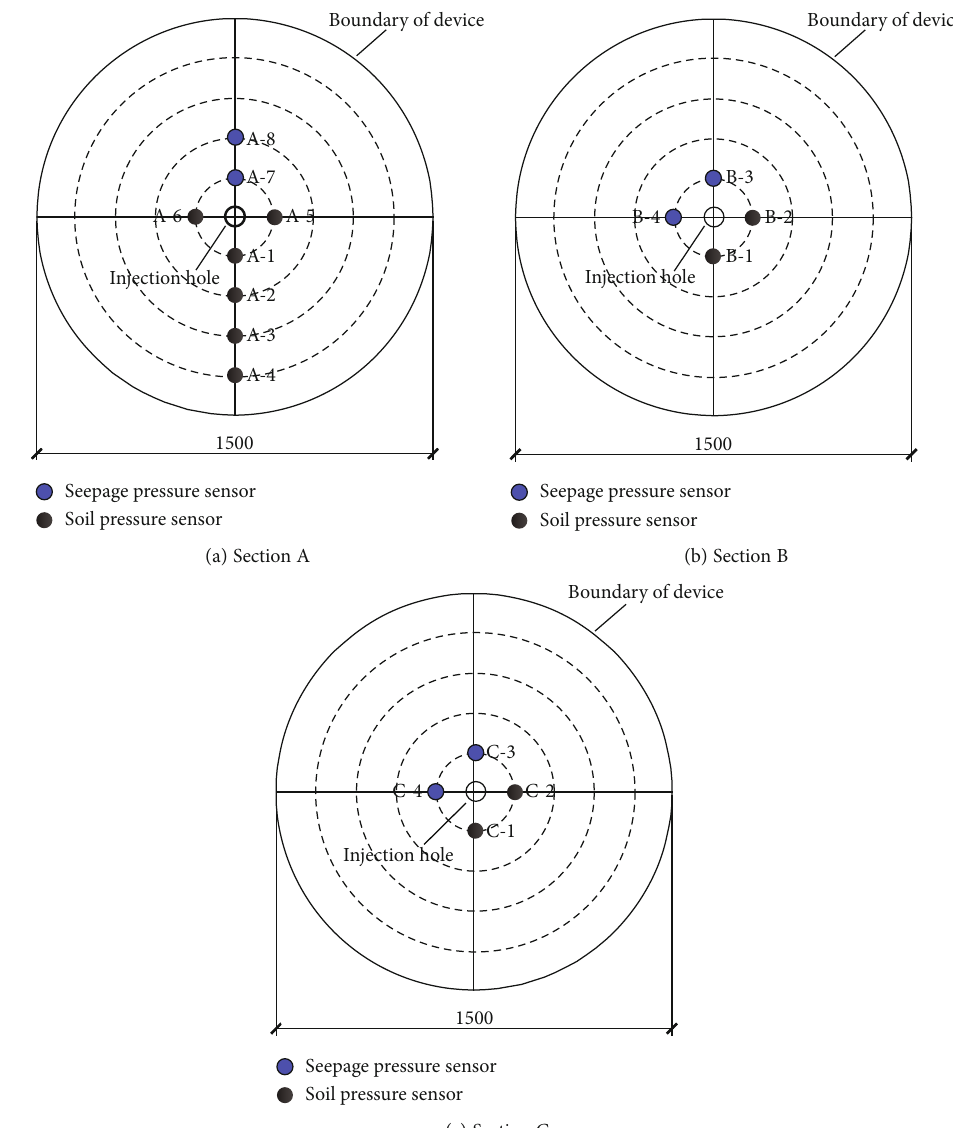
Figure 7: Distribution of soil pressure sensors and seepage pressure sensors (unit